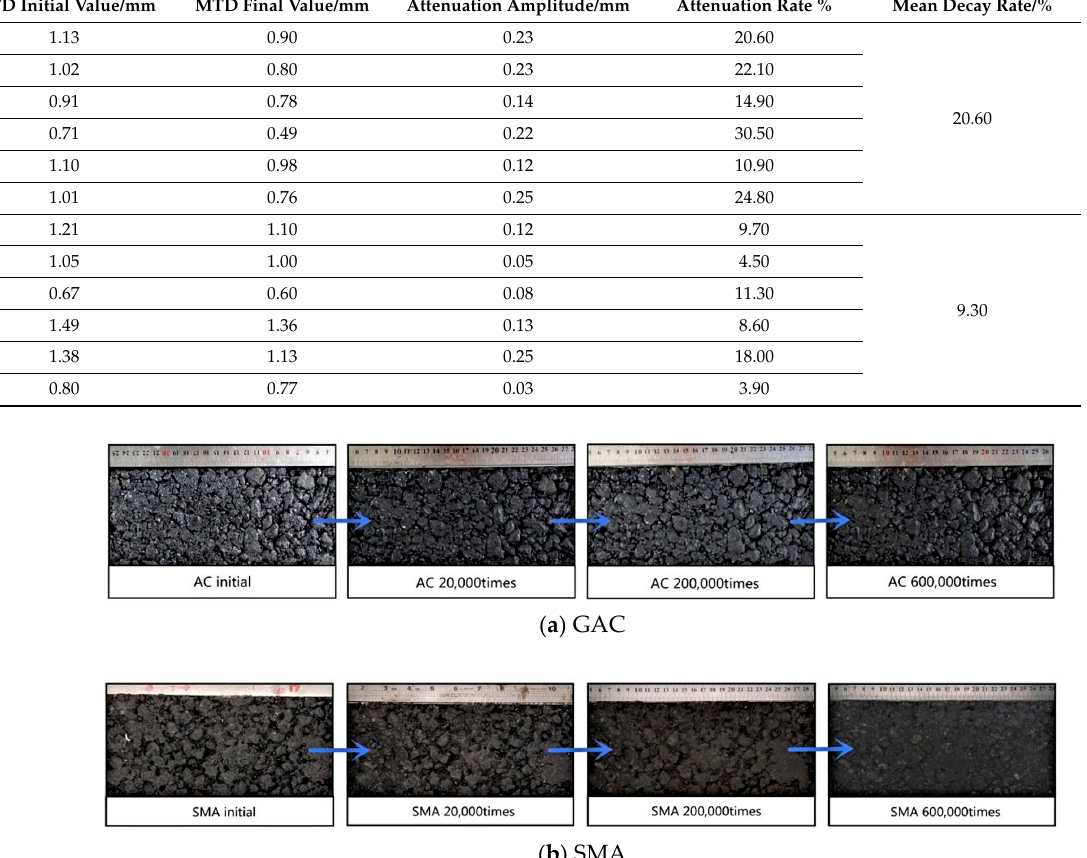
Table 4. Pavement structure depth and loading times.